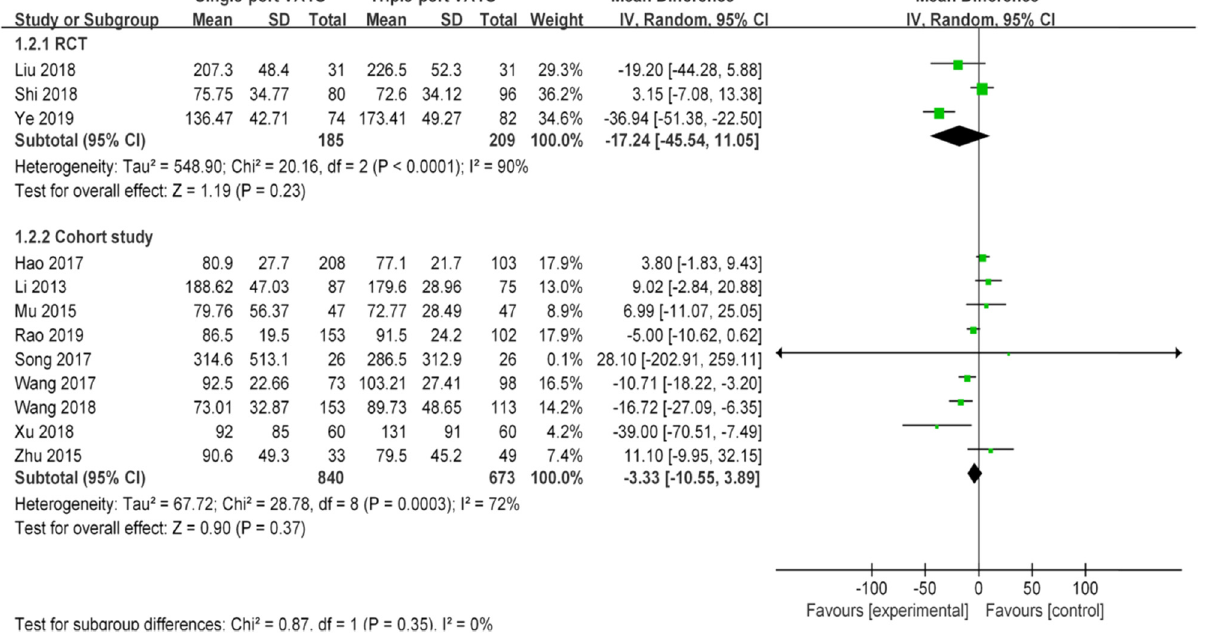
Figure 3: Forest plots of intraoperative blood loss for single - and triple - VATS lobectomy. For each study, the estimated OR ( shown as square ) and its 95% CI ( shown as horizontal line ) were plotted. The pooled OR and 95% CI were plotted as black